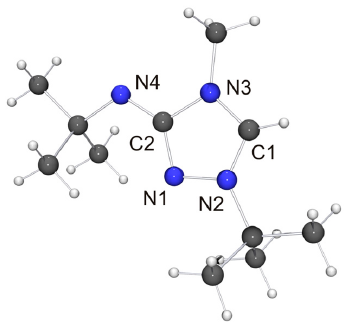
Figure 4. Molecular structure of 6 in the crystal. Selected bond lengths [Å] and angles [°]: C1 ‒ N2 1.315(2), C1 ‒ N3 1.339(2), C2 ‒ N1 1.364(2), C2 ‒ N3 1.420(2), C2 ‒ N4 1.308(2), N1 ‒ N2 1.383(2); N2 ‒ C1 ‒ N3 107.46(13).